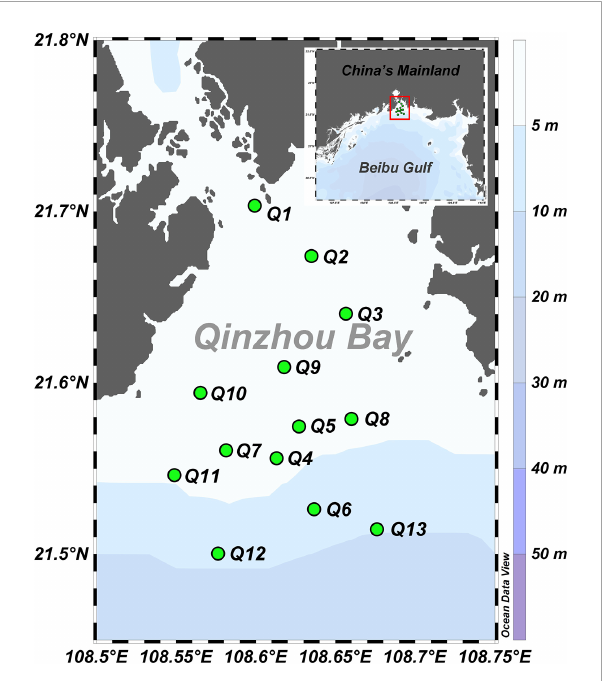
FIGURE 1 Map showing the locations of the 13 surface water sampling stations in Qinzhou Bay, northern Beibu